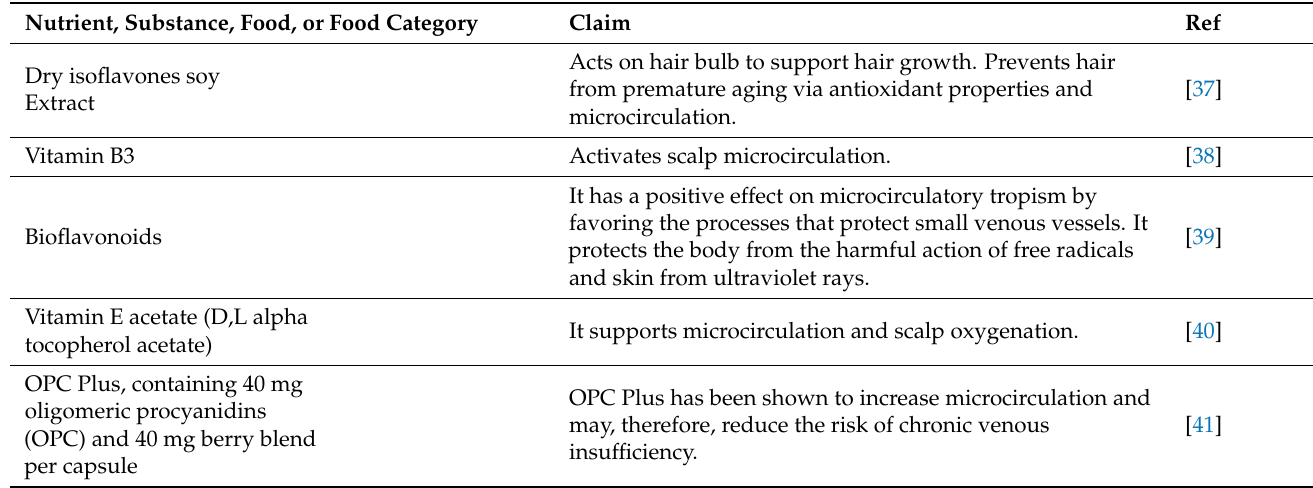
Table 2. List of nonauthorized claims in the EU with the word